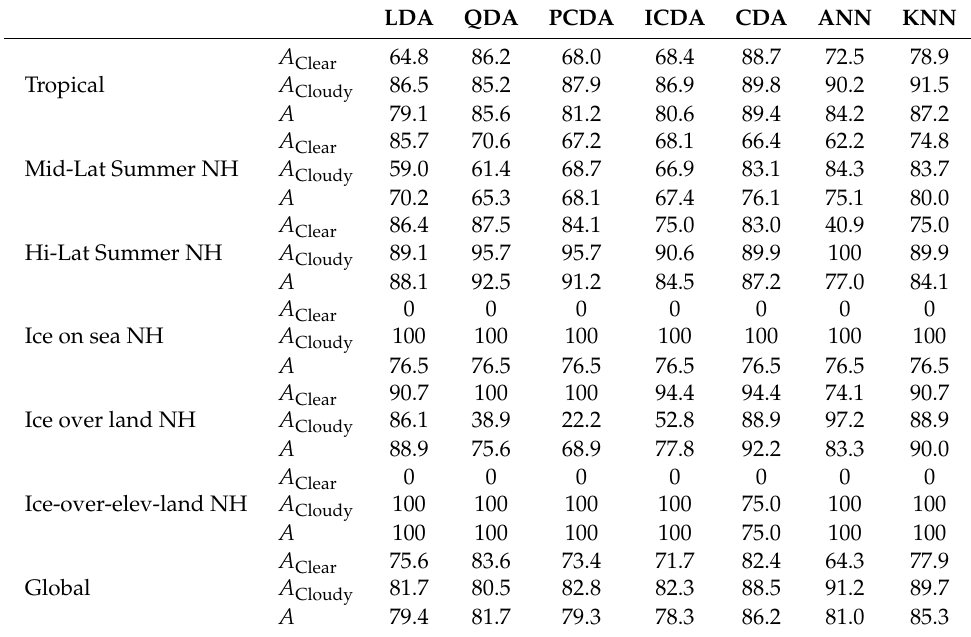
Table 10. Accuracy indicators A , A Clear and A Cloudy of classification methods of Section 3 when validation is made on the gold standard dataset of Section 2.2 and classifications are separate for each climatic zone of Section 2.6. Percentage values are reported for the entire dataset (row Global) and for the different climatic